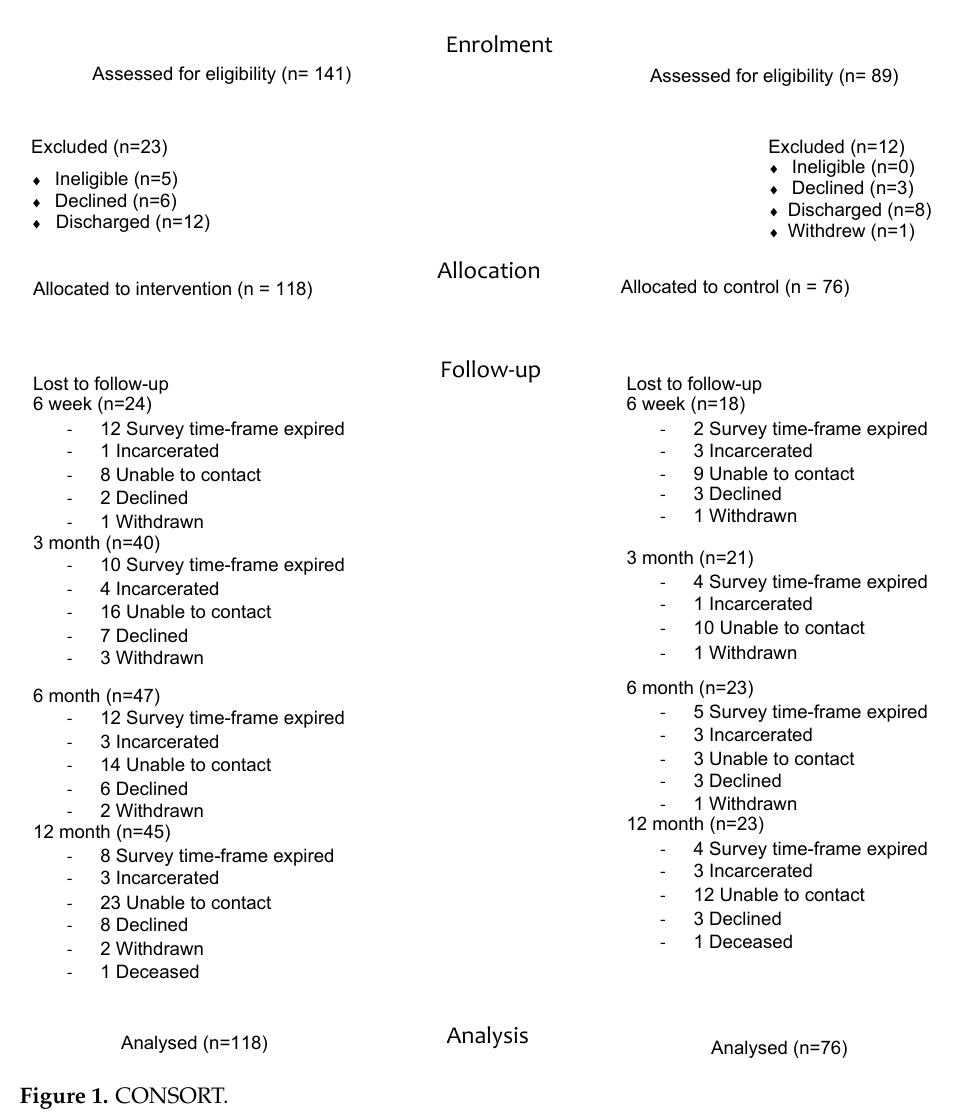
Figure 1. CONSORT.